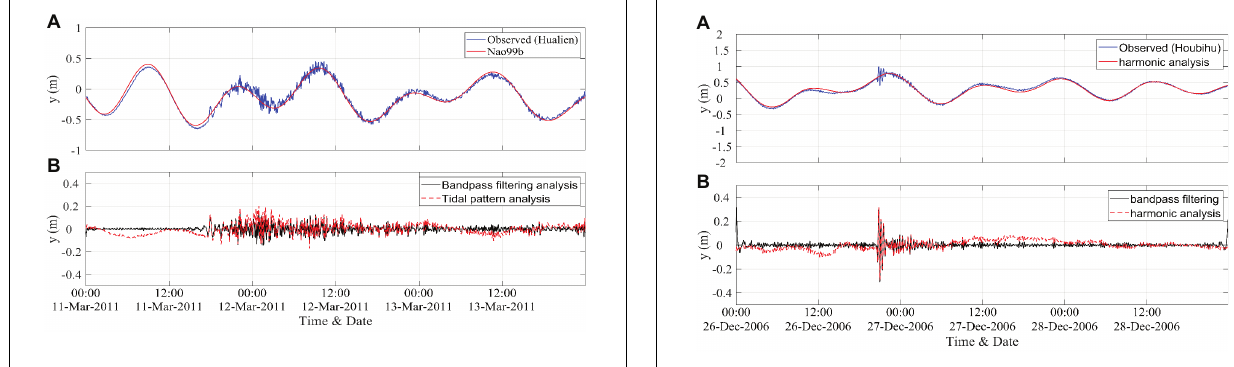
FIGURE 12 | Comparison of the tsunami height extraction by the bandpass filtering method and harmonic analysis. (A) The time series of surface elevation including a tsunami; (B) The extraction of tsunami heights by two